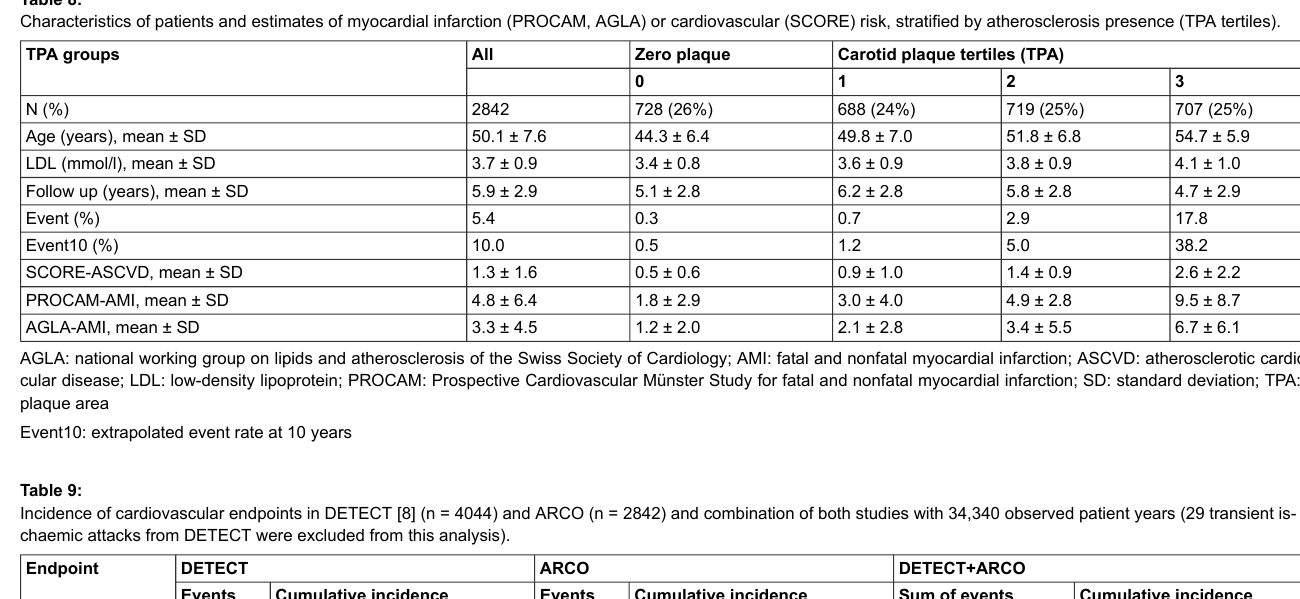
Table 8: Characteristics of patients and estimates of myocardial infarction (PROCAM, AGLA) or cardiovascular (SCORE) risk, stratified by atherosclerosis presence (TPA tertiles). TPA groups All Zero plaque